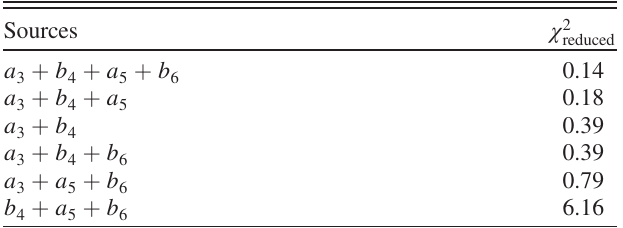
TABLE III. χ 2 of polynomial fits to Q x; reduced Q x; modeled , corresponding to different combinations of possible multipole